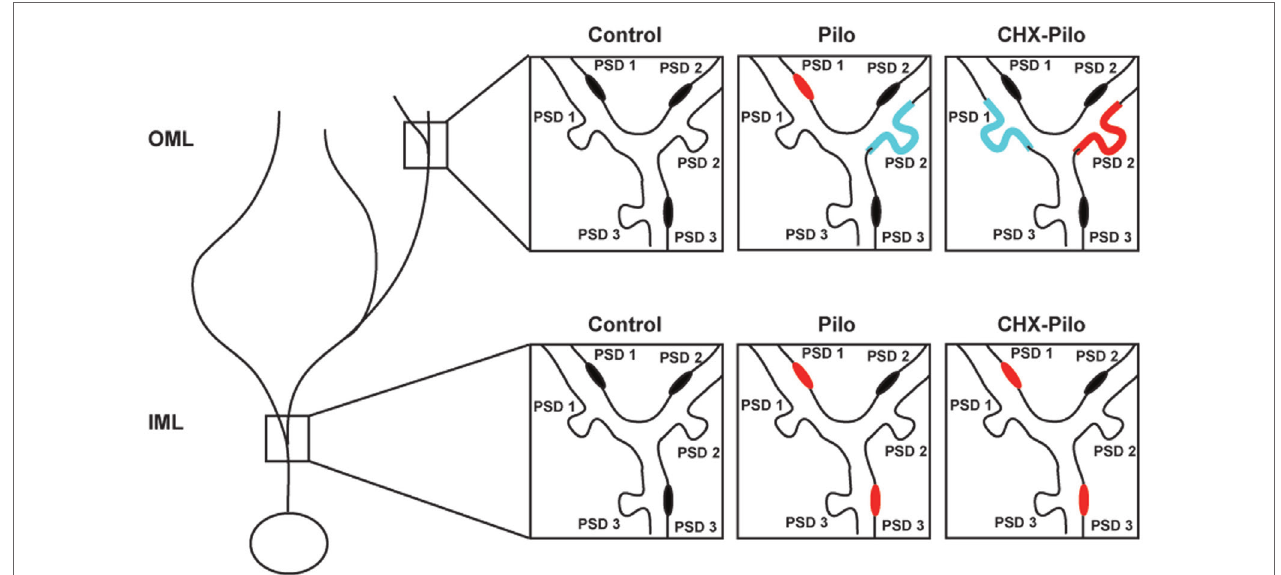
FigUre 5 | schematic view of the changes in the synaptic profiles of the different experimental groups as compared to controls . Synaptic profiles located on the shaft or spine of dendrites in inner (IML) or outer (OML) molecular layer were identified as PSD1, PSD2, or PSD3. Red denotes type and location of synaptic profile showing a significant increase in density as compared to control animals. Blue represents synaptic types and location that were significantly decreased as compared to control animals. Pilo – animals subjected to pilocarpine-induced status epilepticus . CHX + Pilo – animals subjected to pilocarpine- induced status epilepticus and co-injected with cycloheximide.